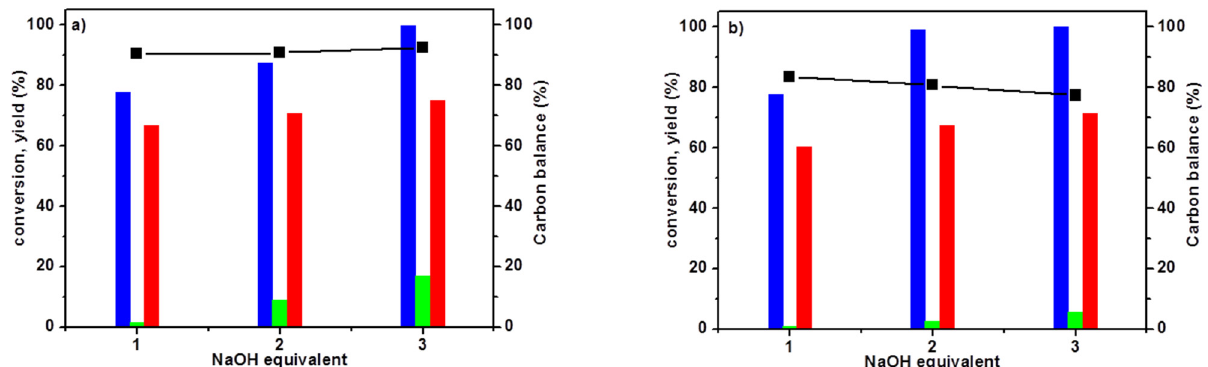
Figure 5 . Effect of NaOH amount on conversion and yield to products in the presence of ( a ) Au/AC_PVA and ( b ) Au/AC_PVP catalysts: ( ■ ) HDO conversion, ( ■ ) AA yield, ( ■ ) HHA Yield, ( ■ ) Carbon balance. Reaction conditions: HDO 42 mmol L − 1 , 20 mL H 2 O, nHDO/nAu =250, 110 °C, 800 rpm, 15 bar air, 4 h, stabilizer/Au weight ratio of 1.2.